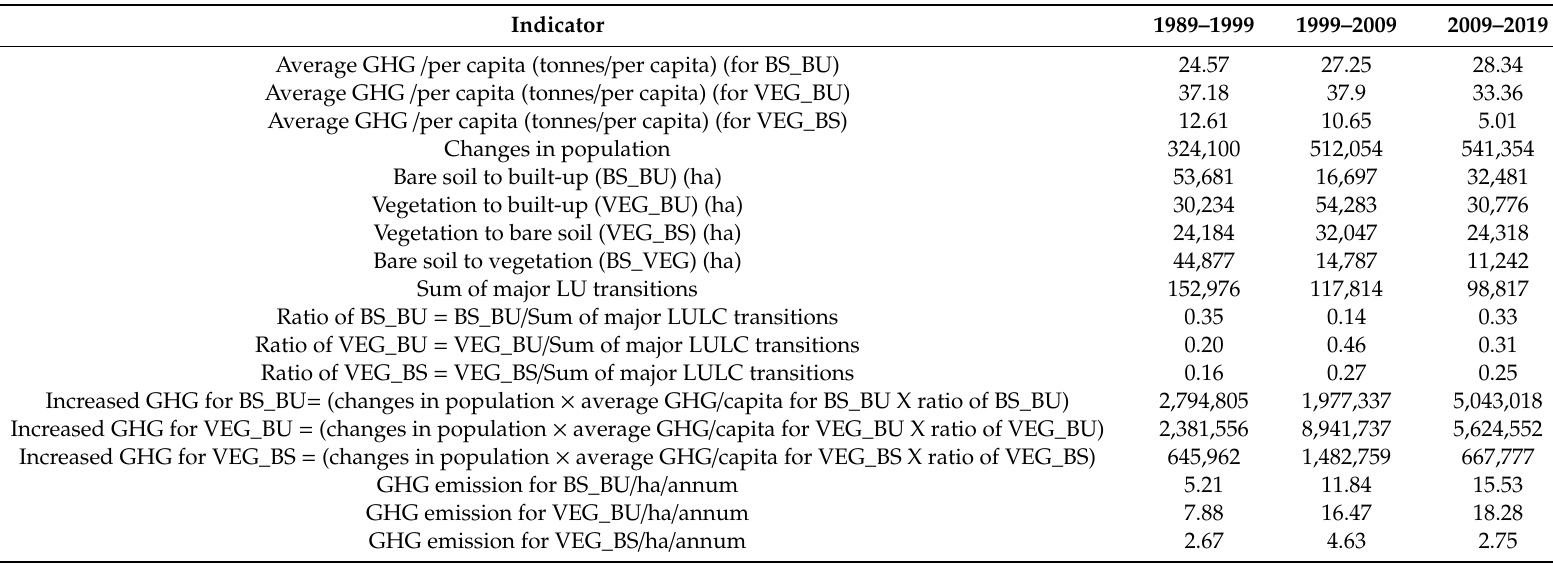
Table 8. Estimating GHG emissions for the changes of ‘bare soil to built-up (BS_BU)’, ‘vegetation to built-up (VEG_BU)’, and ‘vegetation to bare soil (VEG_BS) for the study